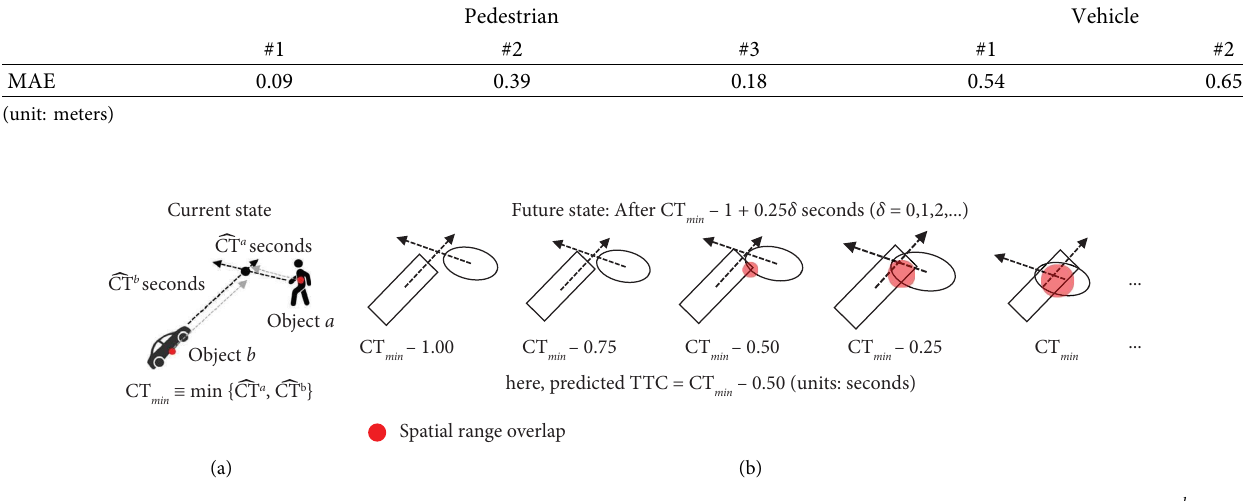
Figure 7: Determination of risk existence and prediction of time-to-collision (TTC): (a) CT two spatial ranges overlap successively more than three intervals, the predicted TTC is calculated as the frst overlap, and if the predicted TTC is smaller than the TTC threshold, the collision risk is regarded to